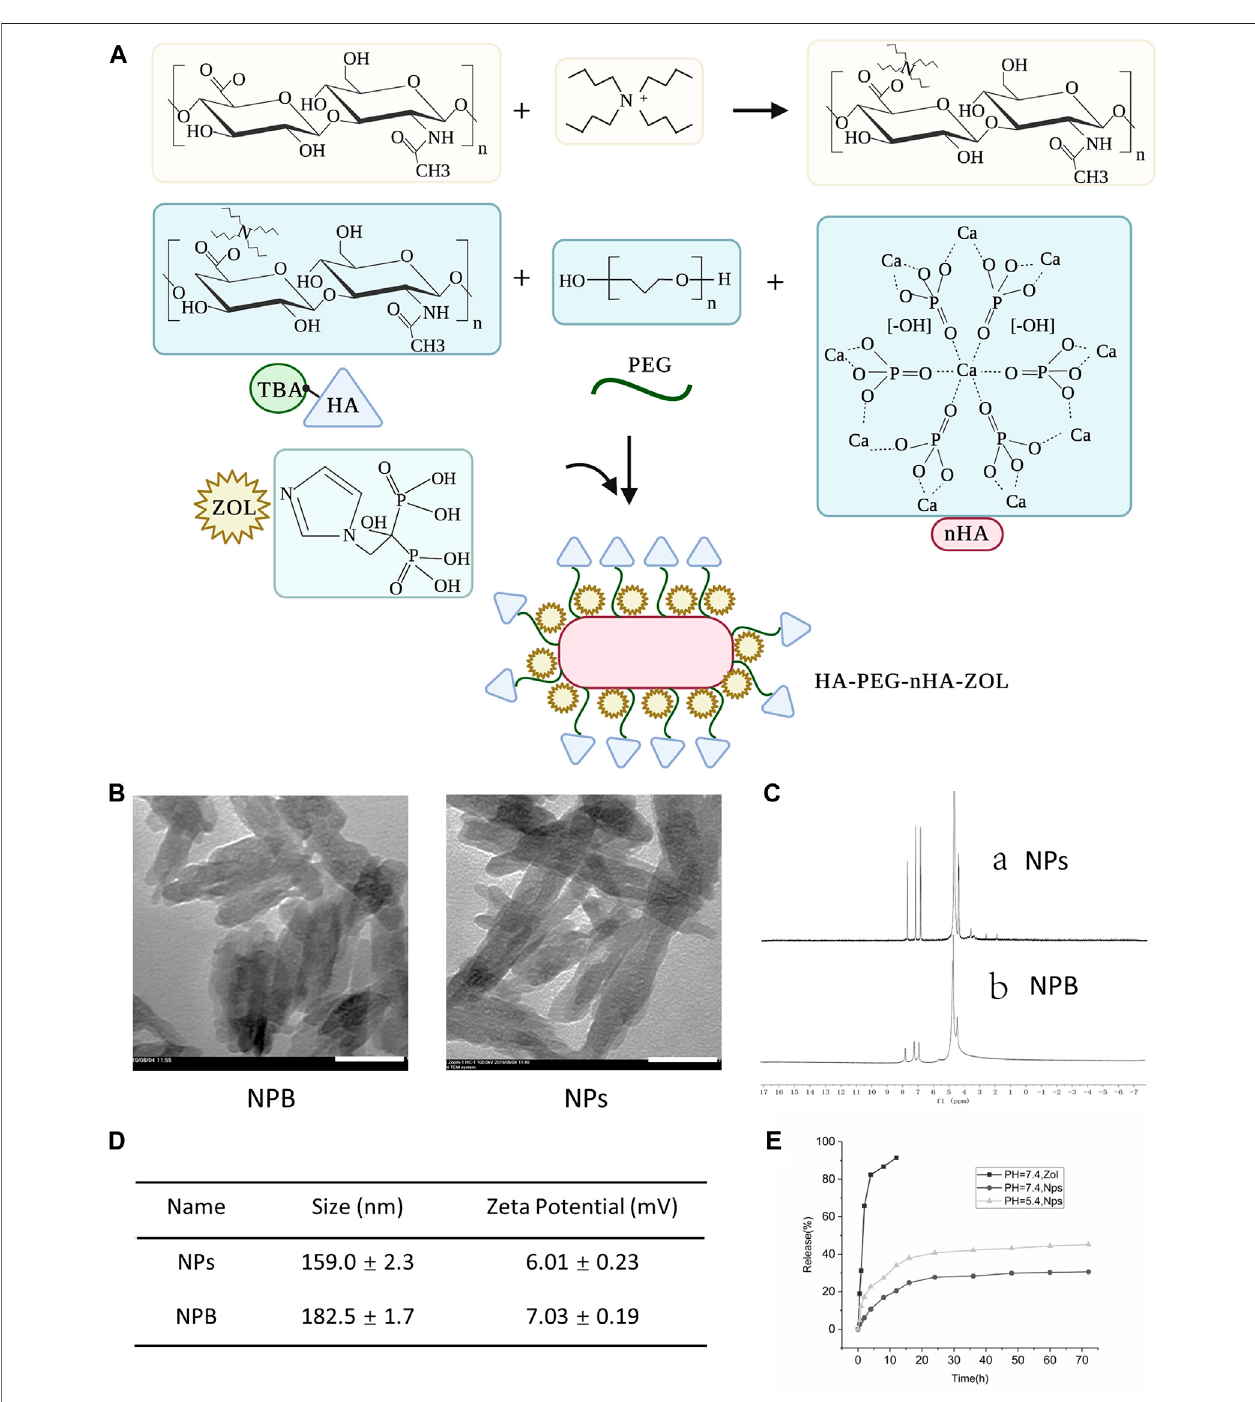
FIGURE 1 | Characterization of blank nanoparticles (NPB) and zoledronic acid-loaded nanoparticles (NPs). (A) Schematic diagram of the construction of nanoparticles. (B) TEMimagesofblanknanoparticlesanddrug-loadednanoparticles.Scalebar=50 nm. (C) Magneticresonanceimagesofdrug-loadednanoparticles and blank nanoparticles. (D) Average size and zeta potential of the nanoparticles. (E) Drug release curve of the nanoparticles.